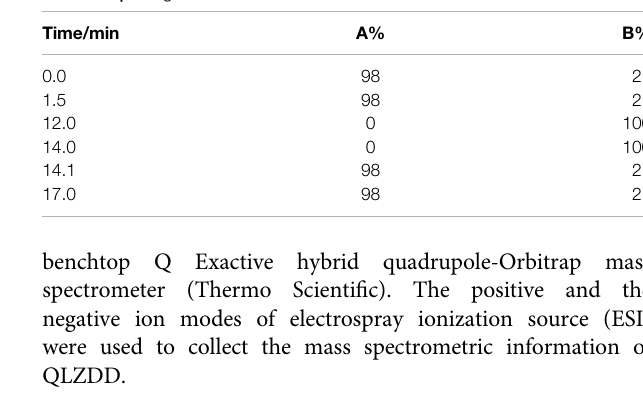
TABLE 2 | The gradient elution